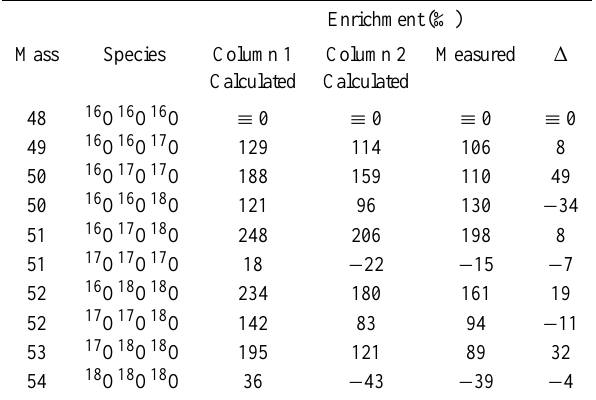
Table 5. Exit channel specific rate coefficients for the formation of 50 O 52 O 3 and 3 . The parameters of the calculations are defined in appendix and determined from specific rates coefficients (see Table probability for an incoming atom to be attached to the knock-on atom of the O 2 molecule is designated by y . Measured ratios are from Janssen et al. (1999)